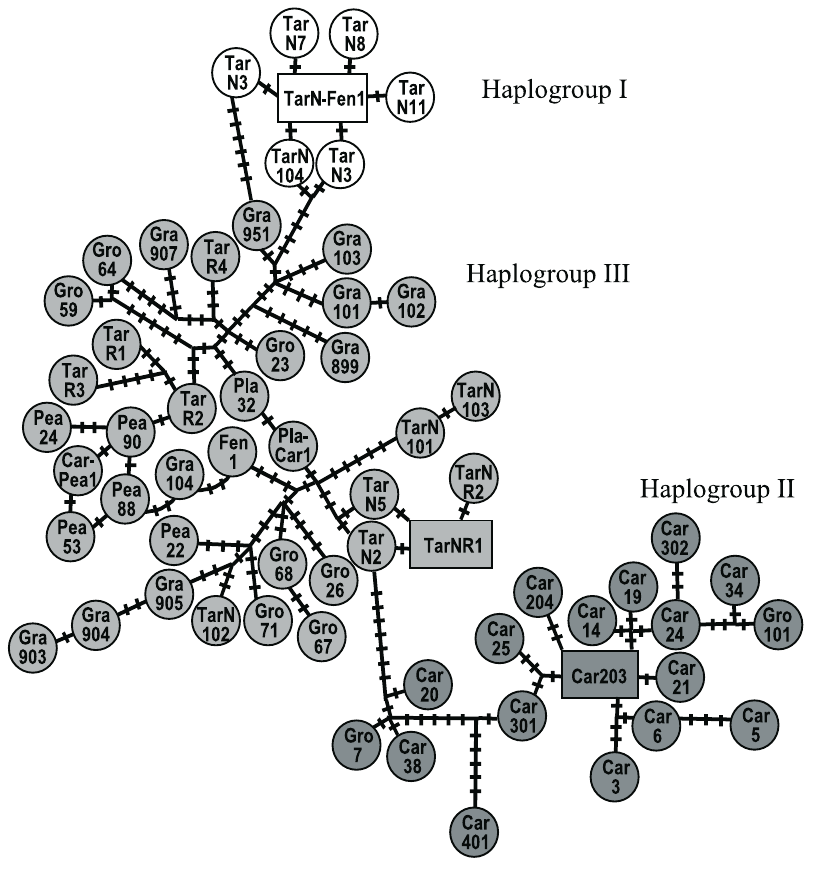
Fig. 4. Minimum spanning network (MSN) of mtDNA haplotypes of reindeer and caribou ( cf. Flagstad & Røed, 2003). Each haplotype is given a three-letter code according to subspecies origin. Norwegian and/or Russian origin of tarandus (Tar) haplotypes is indicated by capital letter N and R, respectively. Bars displayed perpendicular onto the lines connecting the haplotypes represent mutations. Haplogroups I, II and III are indicated with white, dark grey and ligther grey, respectively. Haplotypes estimated to be the most likely common ancestor within each of the three haplogroups are displayed as